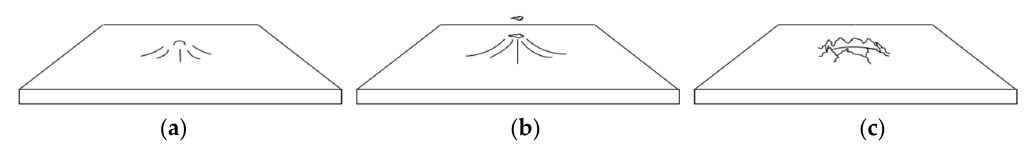
Figure 3. Failure steps of bulging ( a ), discing ( b ), and petaling ( c ) for metallic square coupons when subjected to underwater explosion tests.